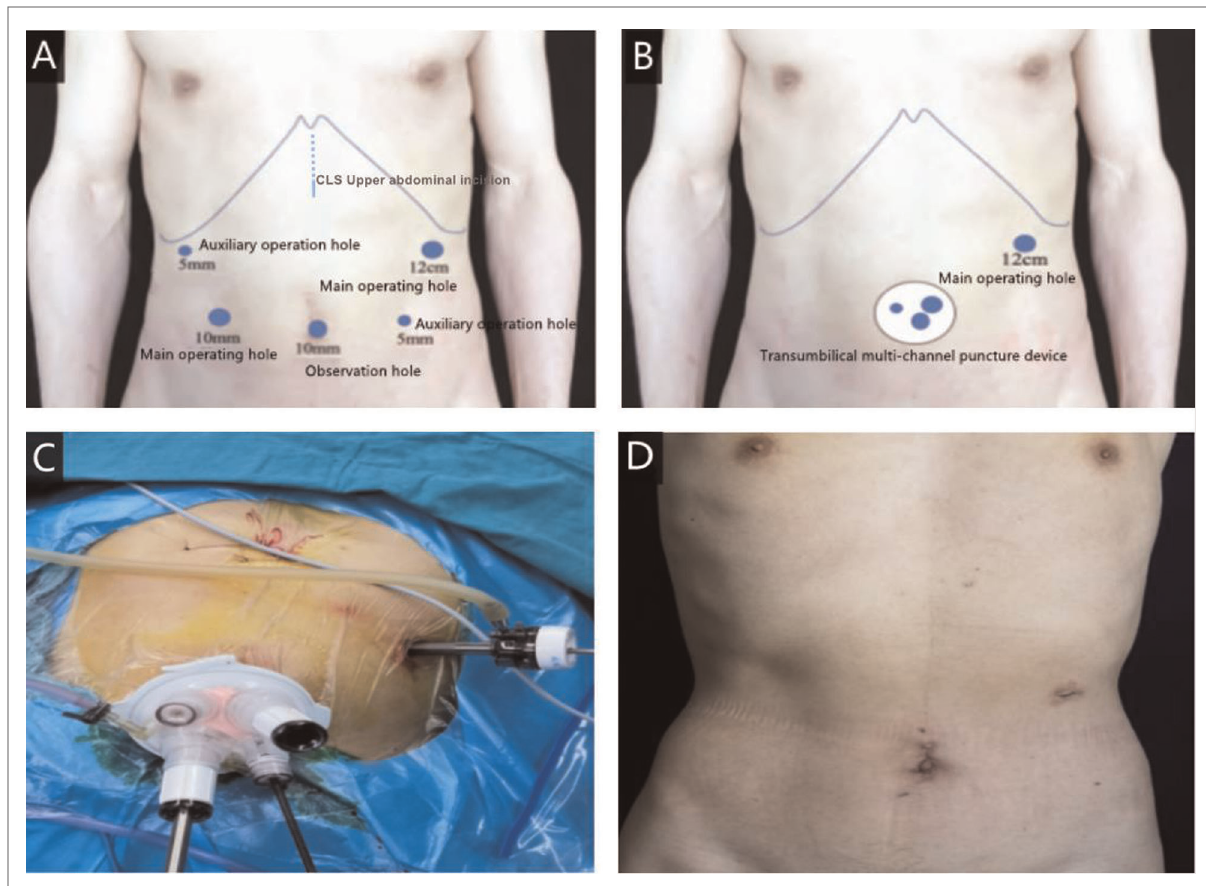
FIGURE 1 ( A ) the layout of the surgical puncture port of CLS; ( B ) the layout of the surgical puncture port of RPLS; ( C ) intraoperative incision position of RPLS; ( D ) postoperative abdominal wall incision after